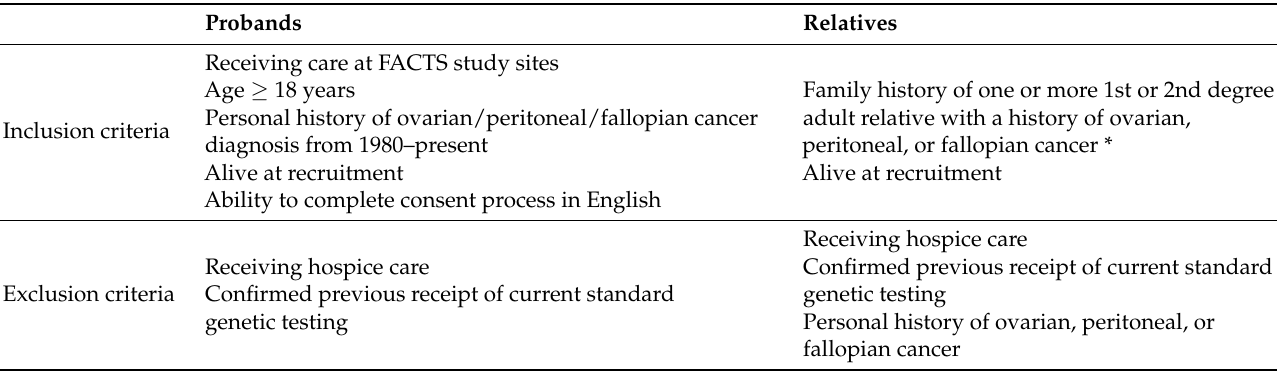
Table 3. Aim 3 inclusionary